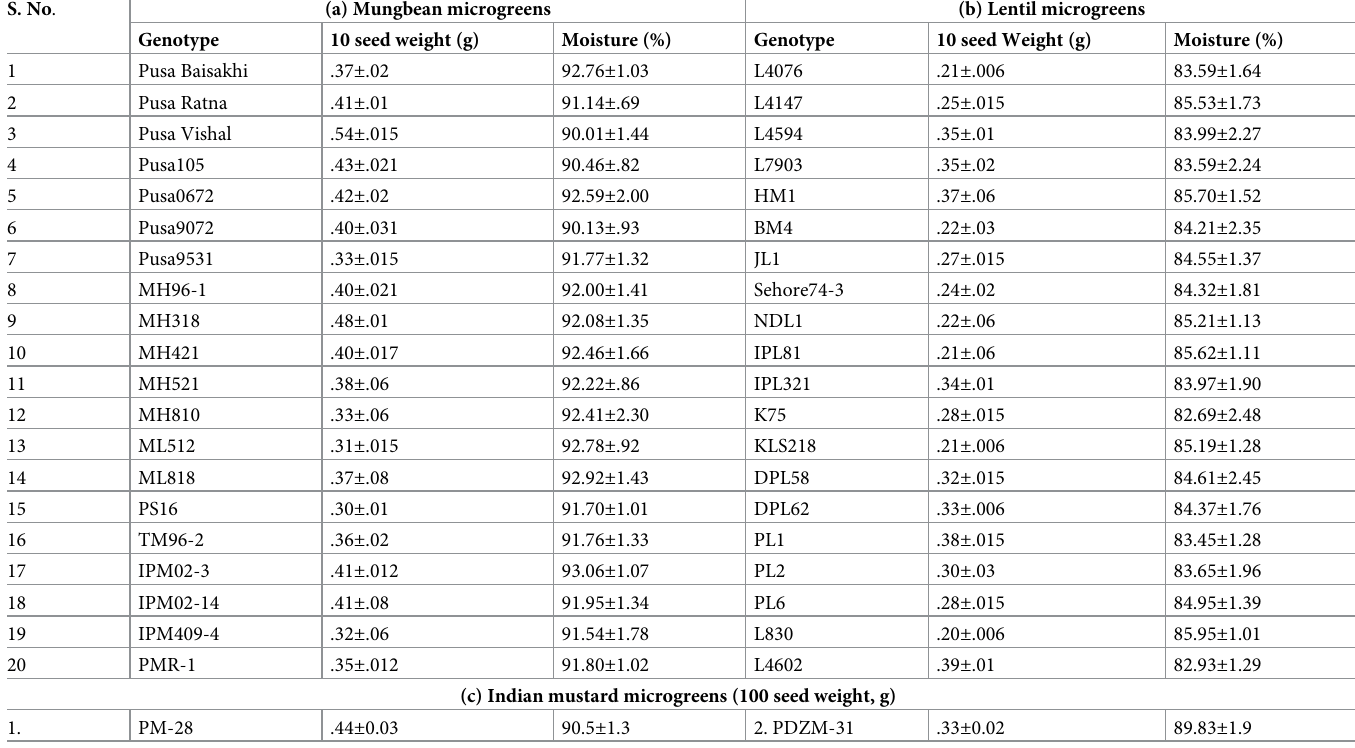
Table 1. Genotypes, seed-weight, and moisture content in the studied lentil, mungbean, and Indian mustard microgreens. S. No